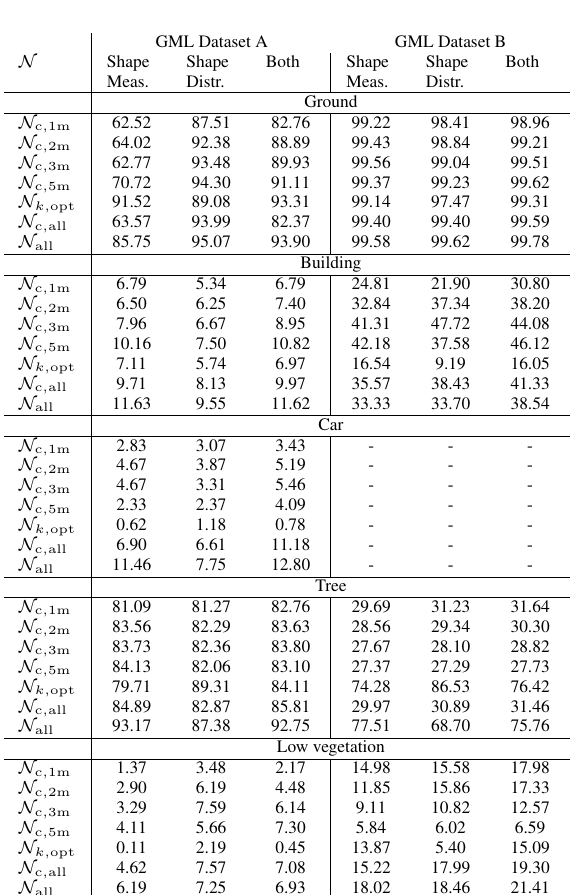
Table 6. Class-wise REC (in %) for different neighbourhood def- initions and different feature sets.